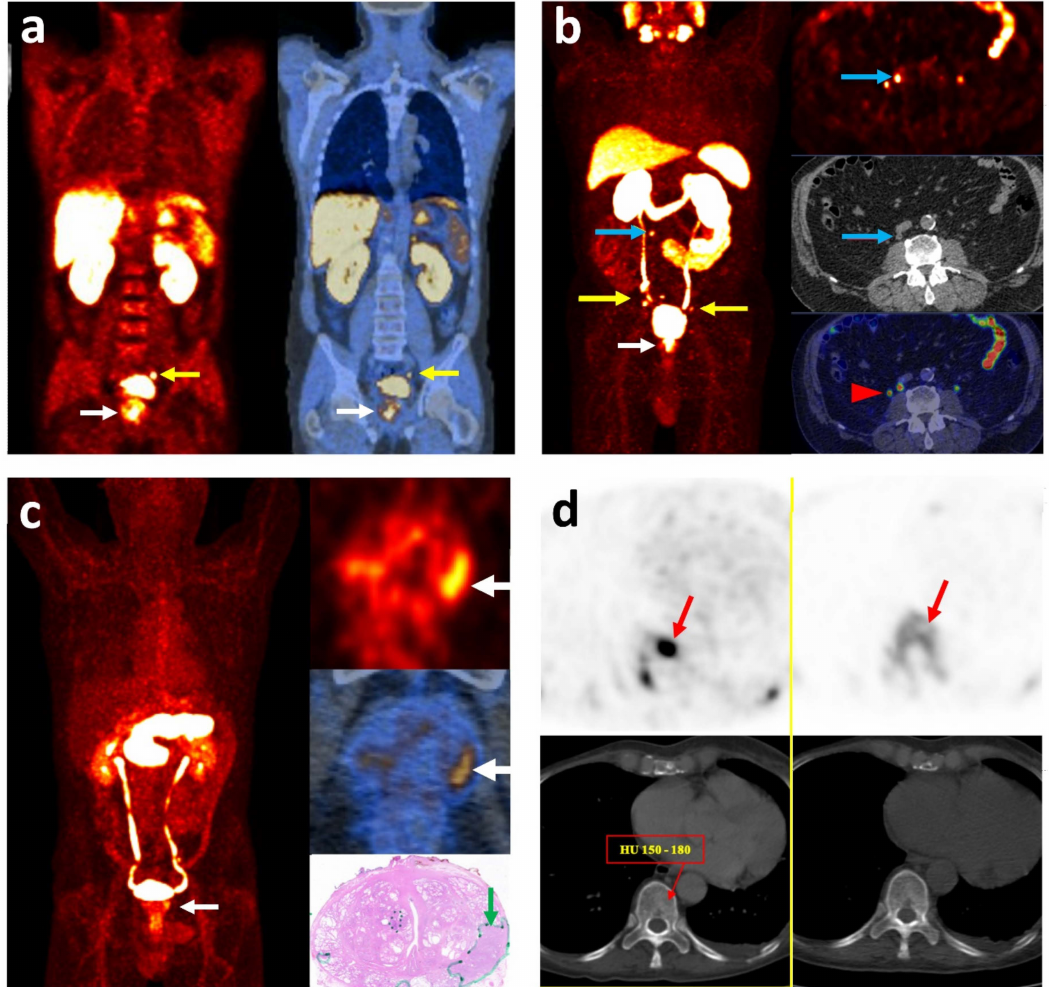
Figure 1. Imaging with different radiotracers localizing primary prostate cancer and its metastasis. ( a ) [ 18 F]choline PET/CT: coronal fused images in a high-risk patient with GS = 8 and PSA = 9.6 ng/mL: primary lesion in the prostate gland (white arrow) and a metastatic lymph node in the left iliac chain (yellow arrow). ( b ) [ 68 Ga]Ga-PSMA PET/CT: MIP (right) and transaxial (left) images in a high-risk patient with GS = 8 and PSA = 4.8 ng/mL: primary lesion in the prostate gland (white arrow) and multiple metastatic lymph nodes in the pelvis (yellow arrow). An unexpected small lymph node is also detected in the upper retroperitoneal region (blue arrow). The red arrowhead shows the physiologic activity in the right ureter. ( c ) [ 68 Ga]Ga-RM2 PET/CT: MIP (right), transaxial (left) images and pathology section (right lower) in a high-risk patient with pT3a N1 (1/23) and GS = 9: primary lesion in the prostate gland (white arrow). The tumor is outlined with a green line and arrow in the pathology section. ( d ) Transaxial images of [ 18 F]choline PET/CT (left) and [ 18 F]Na PET/CT (right) in a high-risk patient, showing an early bone marrow metastasis (red arrow) without morphological changes on CT. GS: Gleason Score; MIP: Maximum Intensity Projection; PSA: Prostate-Specific